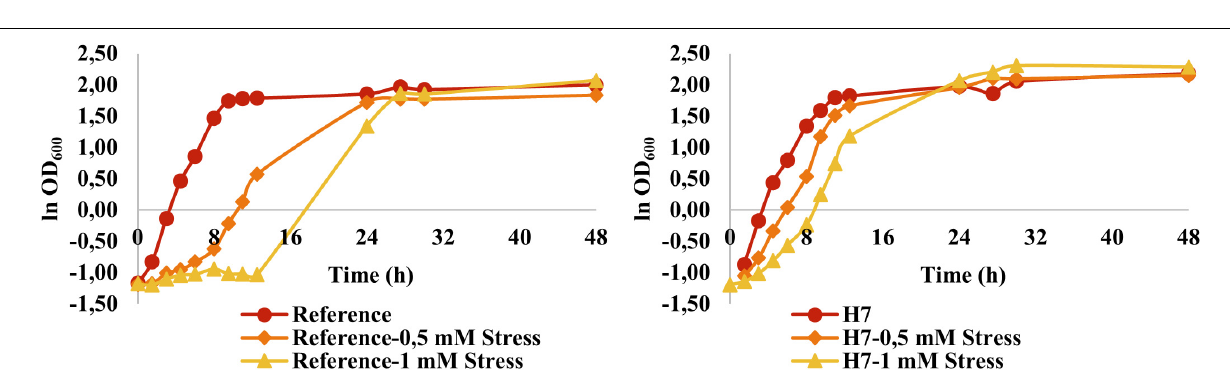
FIGURE 5 | Growth behavior of the reference strain and H7 in the absence and presence of 0.5-mM and 1-mM H 2 O 2 as the oxidative stress factor. The cultures were grown in YMM at 30 - C and 150 rpm for 48